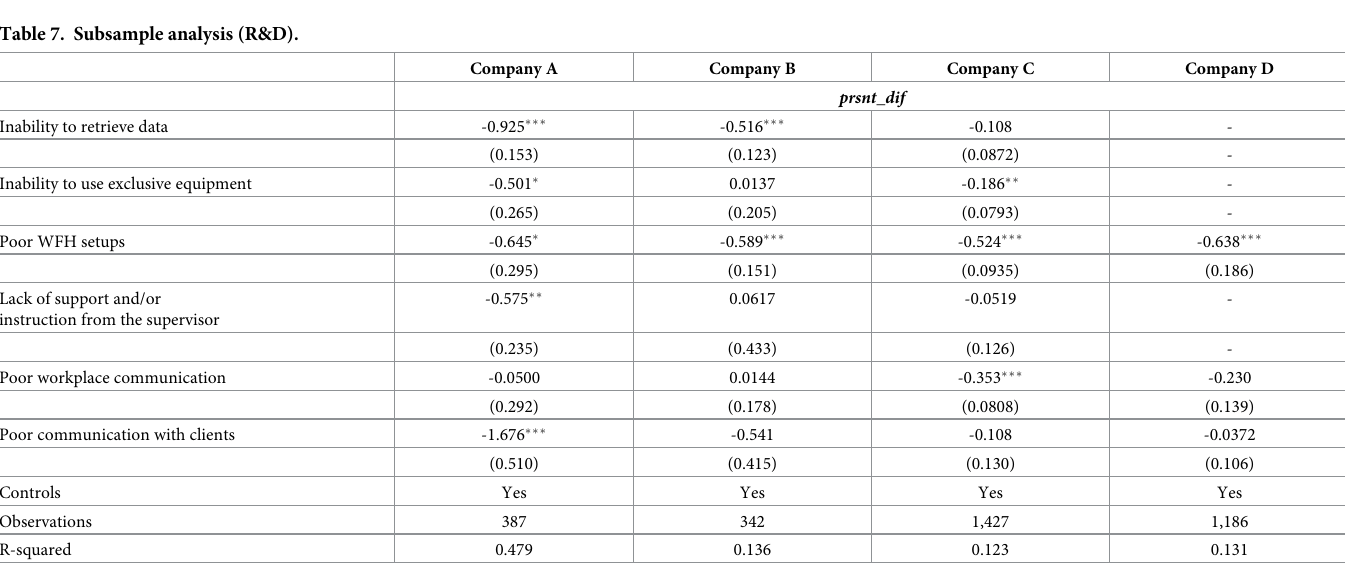
Table 7. Subsample analysis